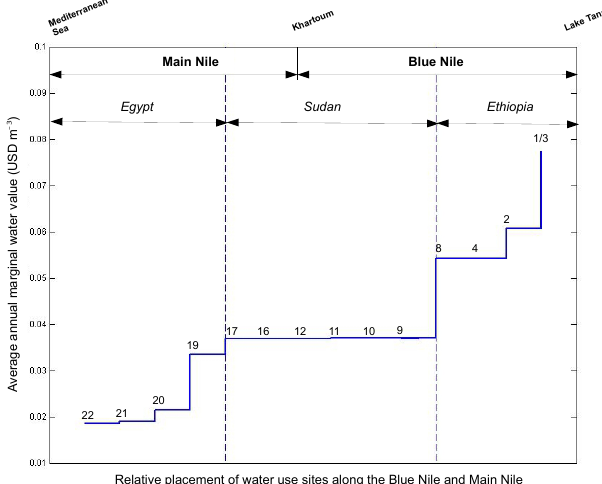
Figure 10. Marginal water value – Blue Nile and Main Nile